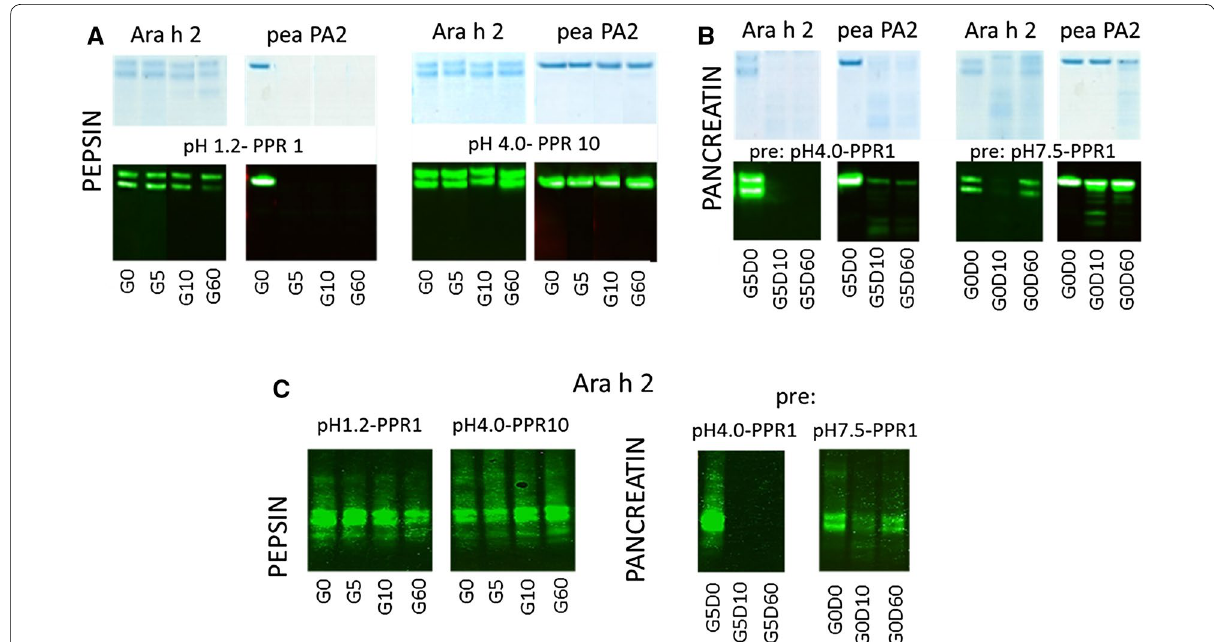
Fig. 3 Selected SDS‑PAGE and immunoblot samples are shown for both albumins, Ara h 2 and pea PA2 albumin. A Ara h 2 displays complete resistance up to 1 h to pepsin at acidic pH, whereas the pea albumin is undetectable after 5 min. Both albumins are unaffected by pepsin at pH 4.0. B Pea albumin PA2 appears to be more resistant to pancreatin than Ara h 2. Surprisingly the disappearance of Ara h 2 is transient when it has not been exposed to acidic pH and active pepsin. C High resistance of Ara h 2 to pepsin is confirmed for IgE. For pea albumin susceptibility could not be confirmed because no sera with pea albumin reactive IgE were found. Susceptibility characteristics of Ara h 2 to pancreatin were also confirmed with